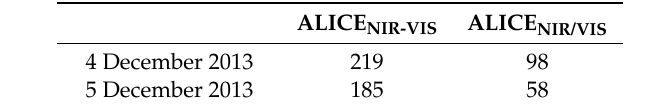
Table 1. Number of anomalous pixels identified by the two ALICE indices in the two analyzed MODIS imagery. MODIS imagery.